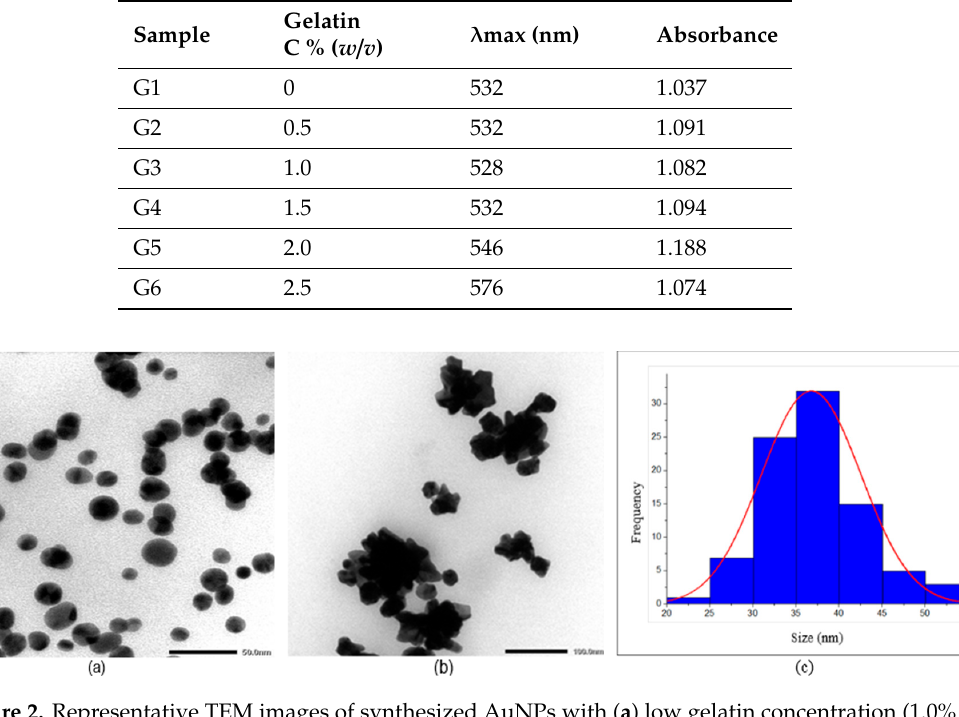
Table 1. UV-Vis results of branched AuNPs synthesized by gelatin with different concentrations of gelatin .